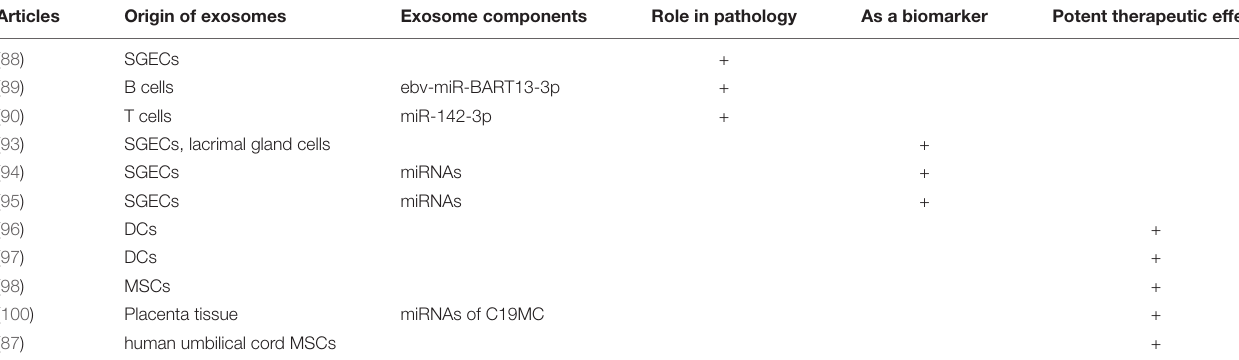
TABLE 1 | A selective overview of studies reporting exosomes in Sjögren’s